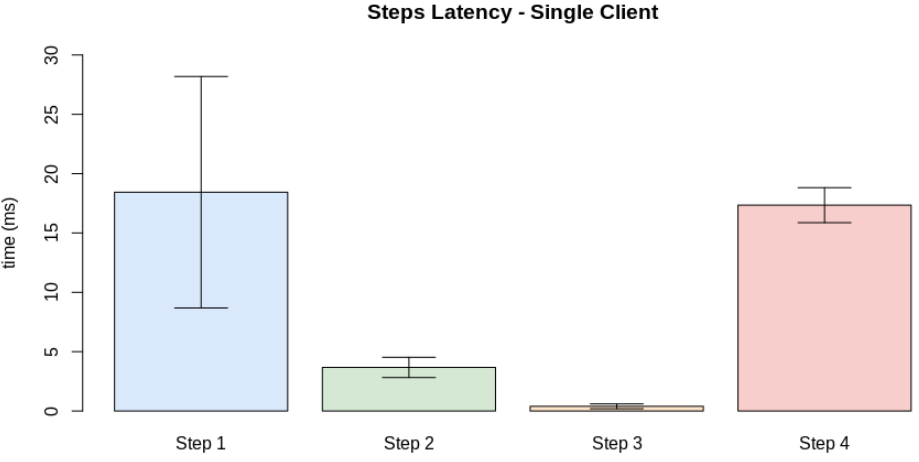
Figure 24. Latency for each of the steps presented in Figure